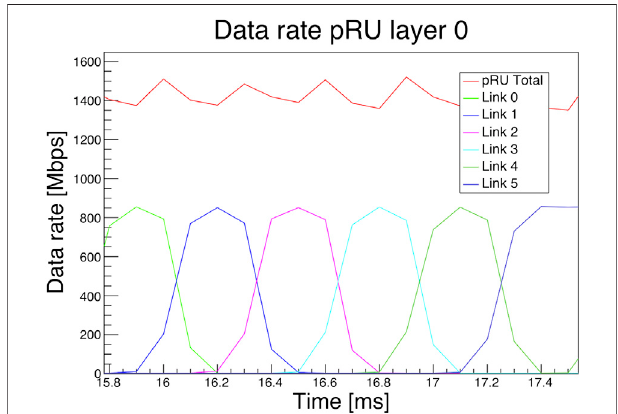
FIGURE 6 | Monte Carlo simulation of data rates for the fi rst layer of the detector with a 230 MeV proton scanning beam and an intensity of 10 7 s − 1 . The beam scans over the detector plane in 65 ms. The plot was published as Figure 1 in Ref. 47, Creative Commons Attribution-Non Commercial-No Derivatives 4.0 International License (CC BY-NC-ND